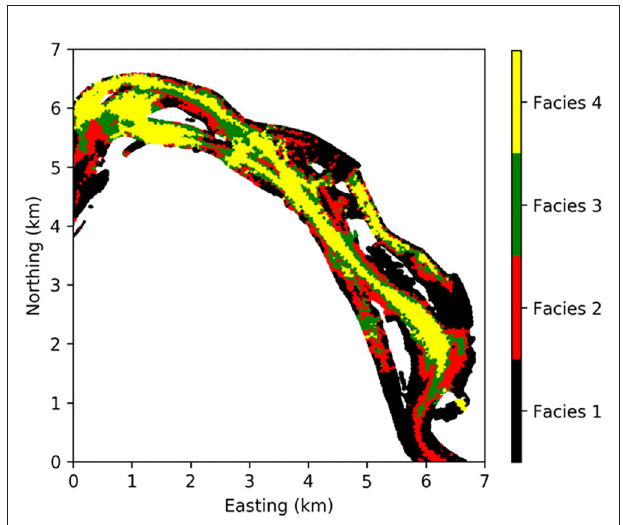
FIGURE 2 | Map of riverbed